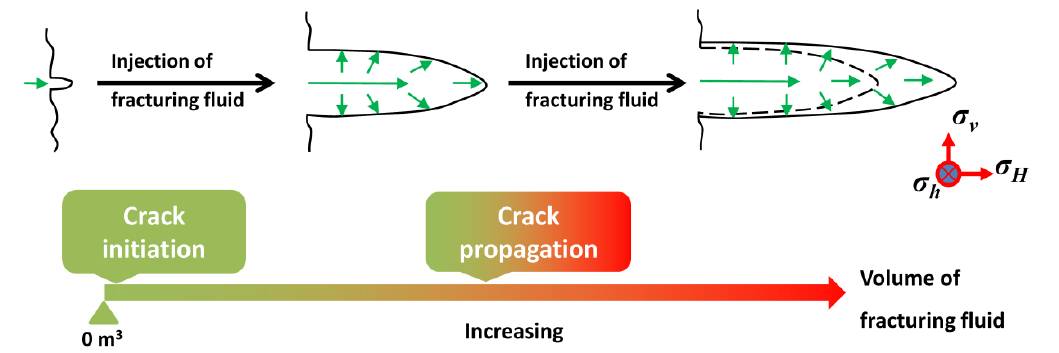
Figure 1: Schematic diagram for the initiation and propagation of hydraulically induced fracture during hydraulic fracturing